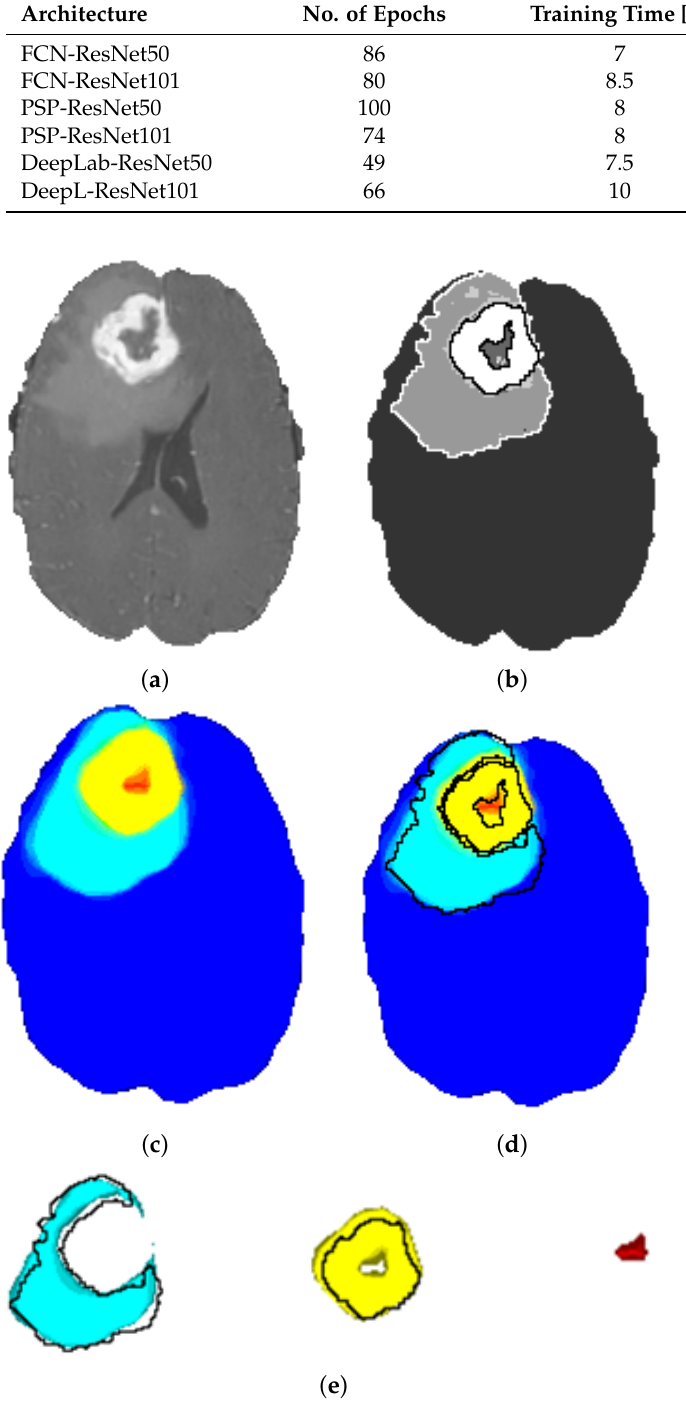
Figure 12. Segmentation Results of the Ensemble Model: ( a ) original image; ( b ) ground truth with annotation contours; ( c ) ensemble segmentation; ( d ) ensemble segmentation with annotation contours; ( e ) ensemble segmentation of ED (turquoise), AT (yellow), NEC (red), Annotation Contours